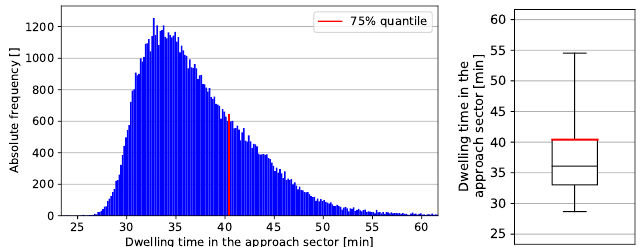
Figure 6. Left : Distribution of flight time within the approach sector to WSSS. Right : Corresponding box plot with median, 25% and 75% quantile (red line) as well as the whiskers located at the 1% and 99% quantile.